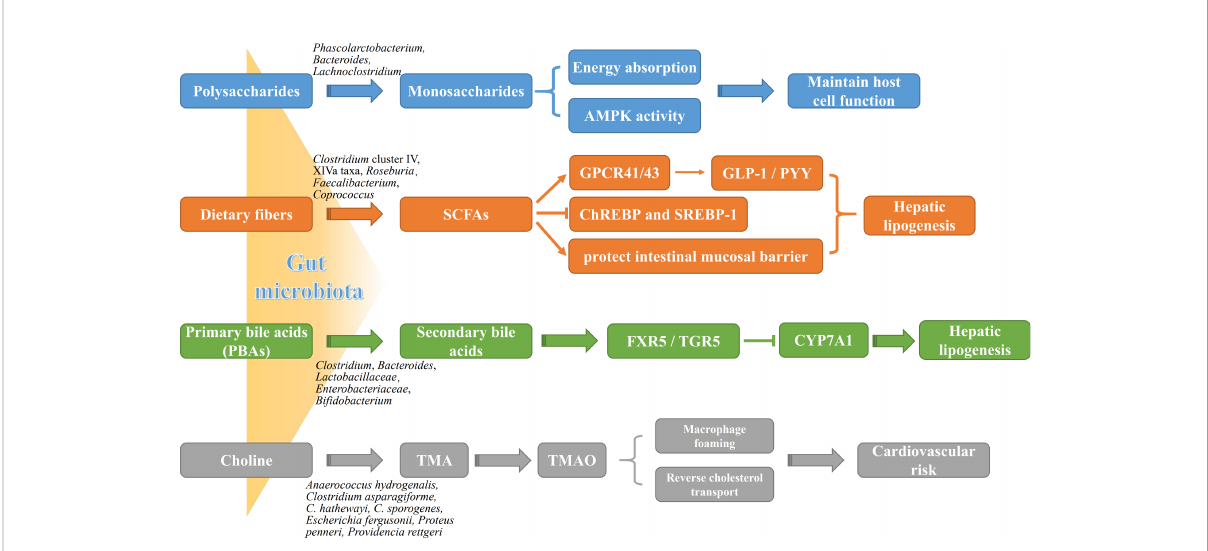
FIGURE 1 The roles of gut microbiota metabolites in NAFLD pathogenesis. Gut microbial metabolites, such as monosaccharides, SCFAs, BAs and TMA, not only are potently involved in energy metabolism of liver and intestinal epithelial cells, but affect directly liver lipogenesis and systemic in fl ammation. AMPK, adenosine monophosphate-dependent protein kinase; ChREBP, carbohydrate-responsive element-binding protein; CYP7A1, cytochrome P450 7A1; FXR, farnesoid X receptor; GLP-1, glucagon-like peptide-1; GPCR41/43, G protein-coupled receptor 41/43; PYY, peptide YY; SREBP-1, sterol regulatory element-binding protein 1; TGR5, takeda G protein receptor 5; TMAO, trimethylamine